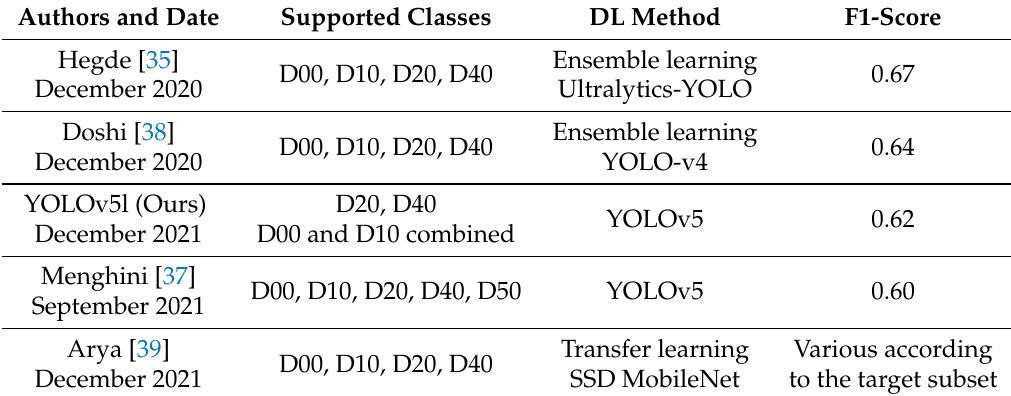
Table 3. State-of-the-art proposals applied to the Road Damage Dataset (RDD) (2020 version) [5]. Authors and